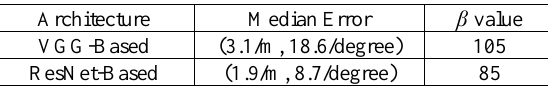
Table 2. Test results with real range frames